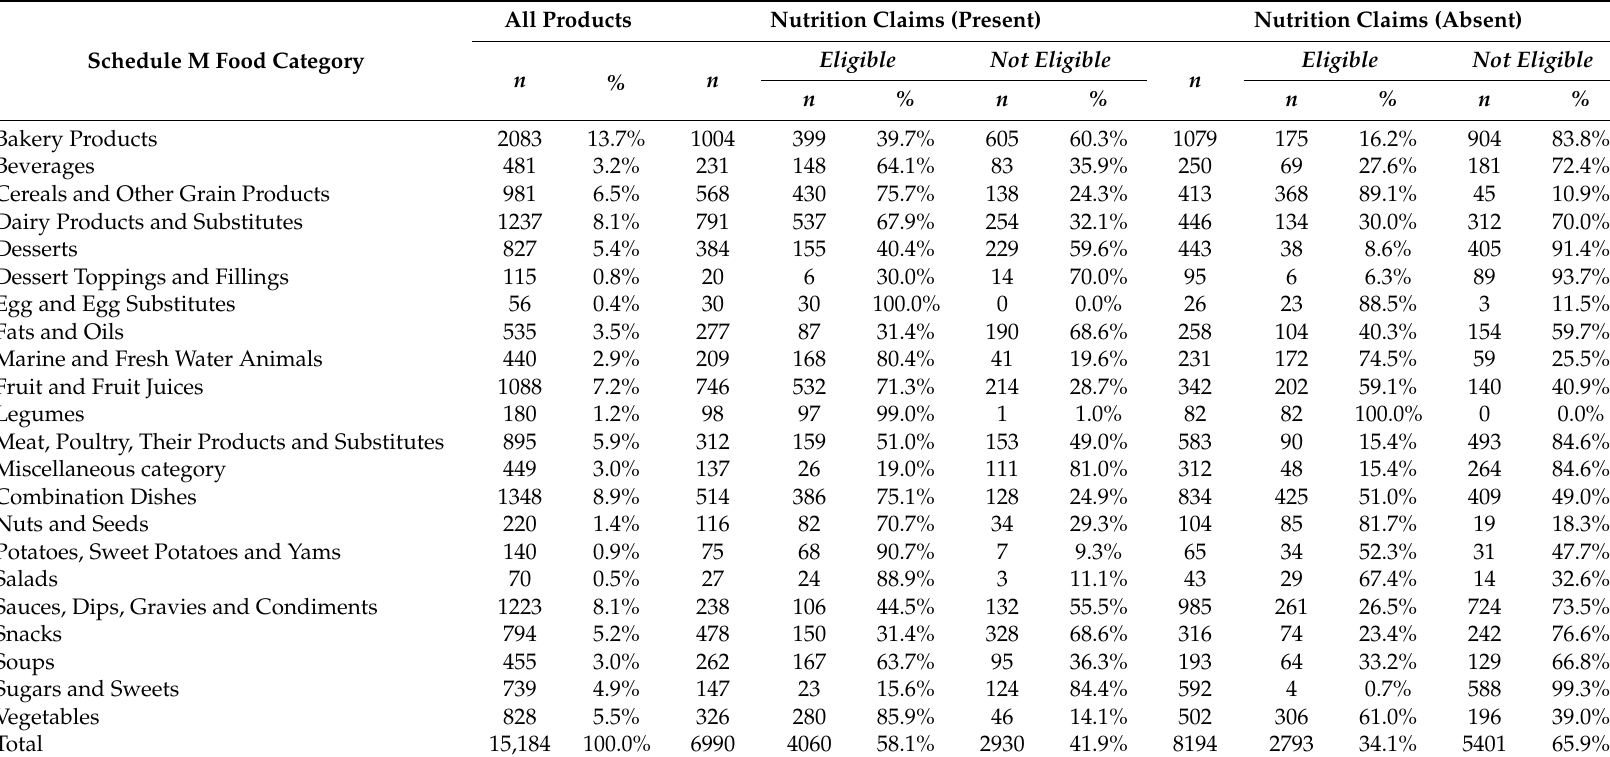
Table 1. Proportion of products carrying nutrition claims that would or would not be eligible to carry such claims according to the FSANZ-NPSC, by Schedule M food category ( n =